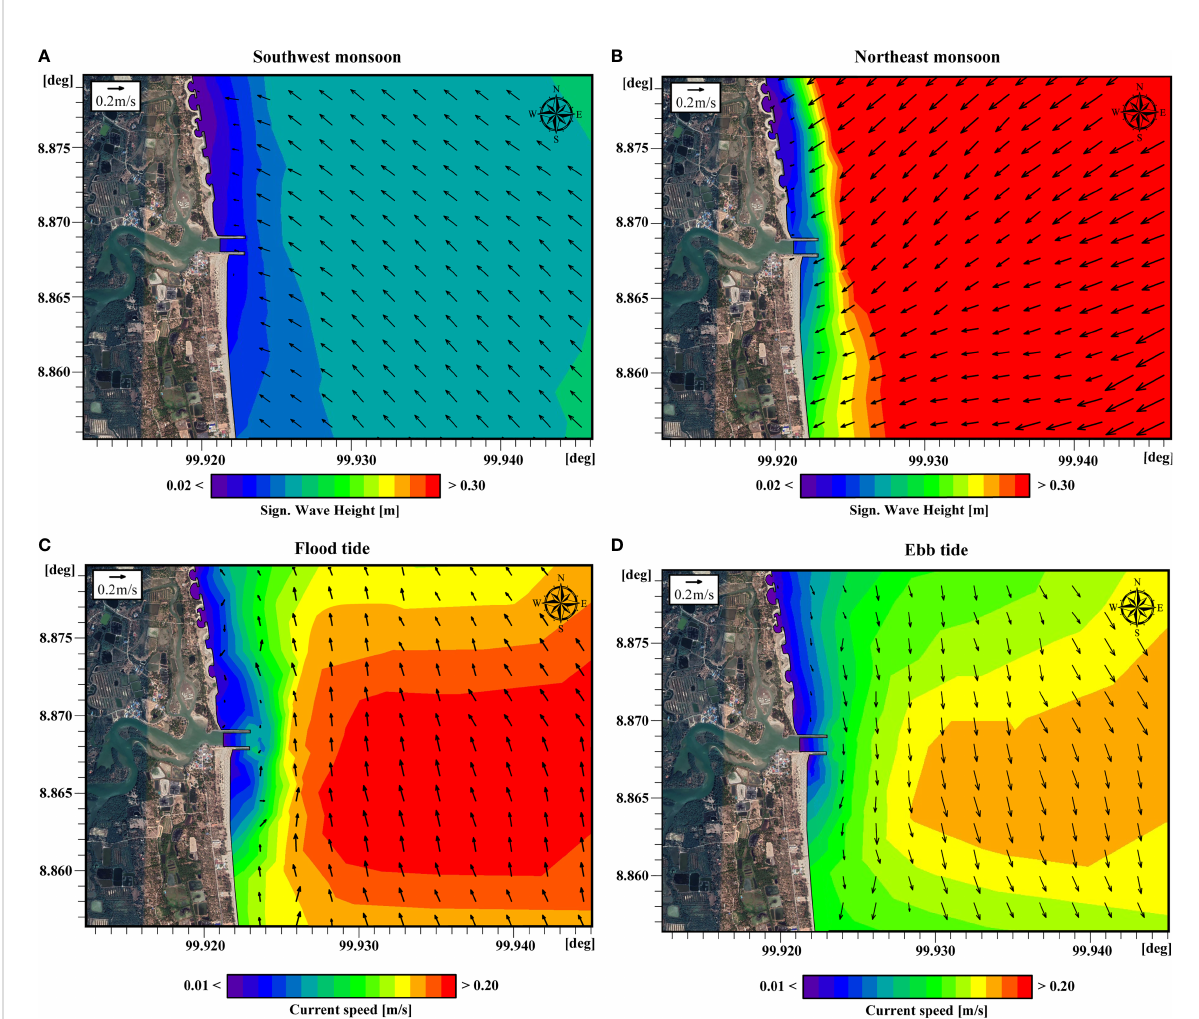
FIGURE 7 Results of MIKE 21 SW and HD at the Krai jetty (A) signi fi cant wave height and direction (arrows) during the southwest monsoon, (B) signi fi cant wave height and direction (arrows) during the northeast monsoon, (C) current speed and direction (arrows) during fl ood, (D) current speed and direction (arrows) during ebb